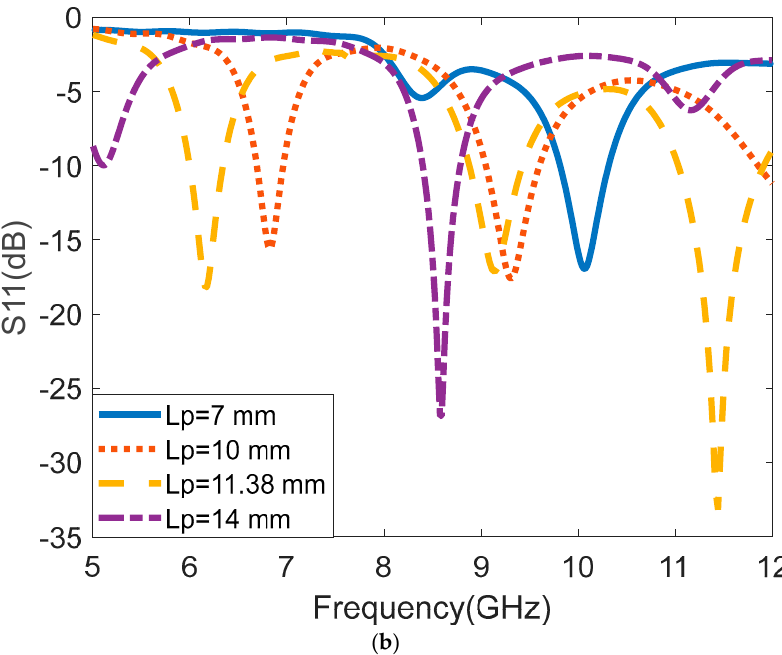
Figure 4. Effect of variation of Wp and Lp on the reflection coefficient, ( a ) S11 for different values of Wp, ( b ) S11 for different values of Lp.